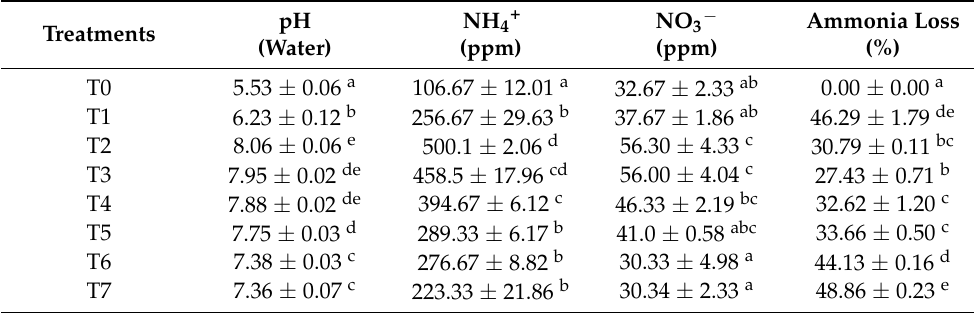
Figure 3. Ammonia volatilization over 28 days of incubation under waterlogged condition. Table 5. Effect of treatments during ammonia volatilization study on soil pH, exchangeable NH 4+ , exchangeable NO 3 − , and ammonia